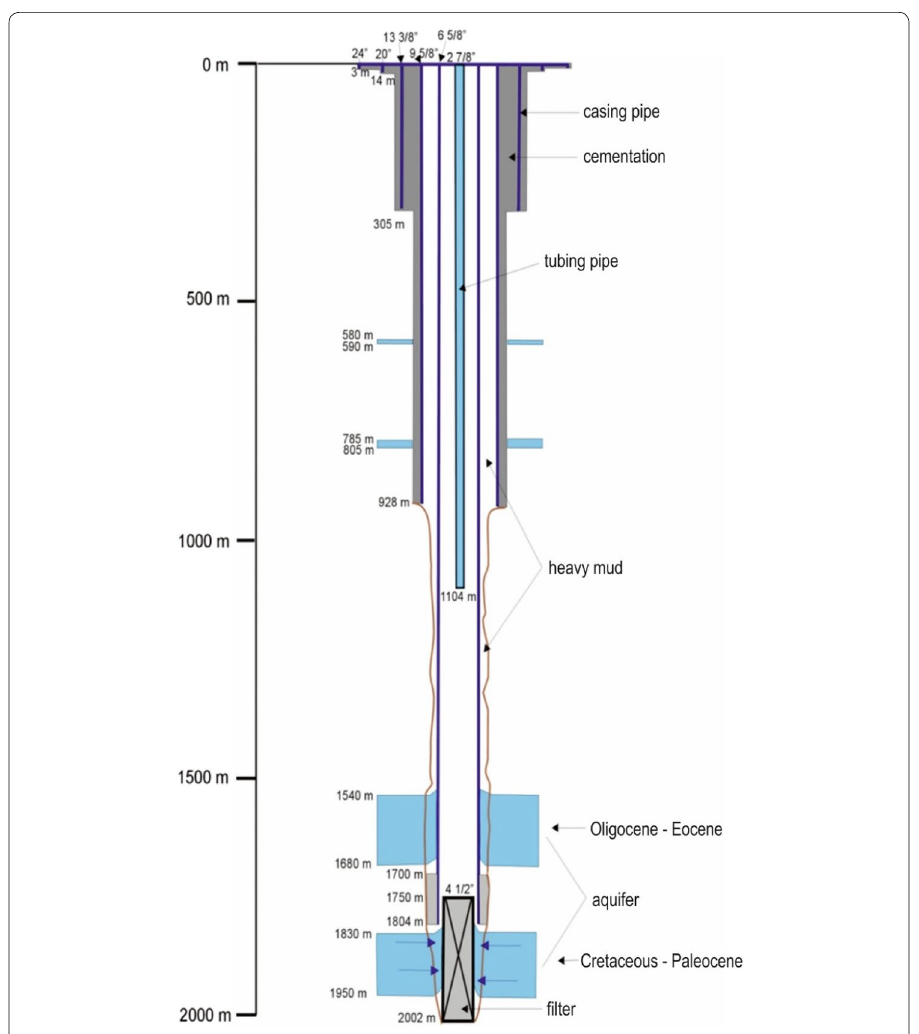
Fig. 10 Schematic structure of the Poręba Wielka IG-1 well in its pre-reconstruction state (Bujakowski et al.